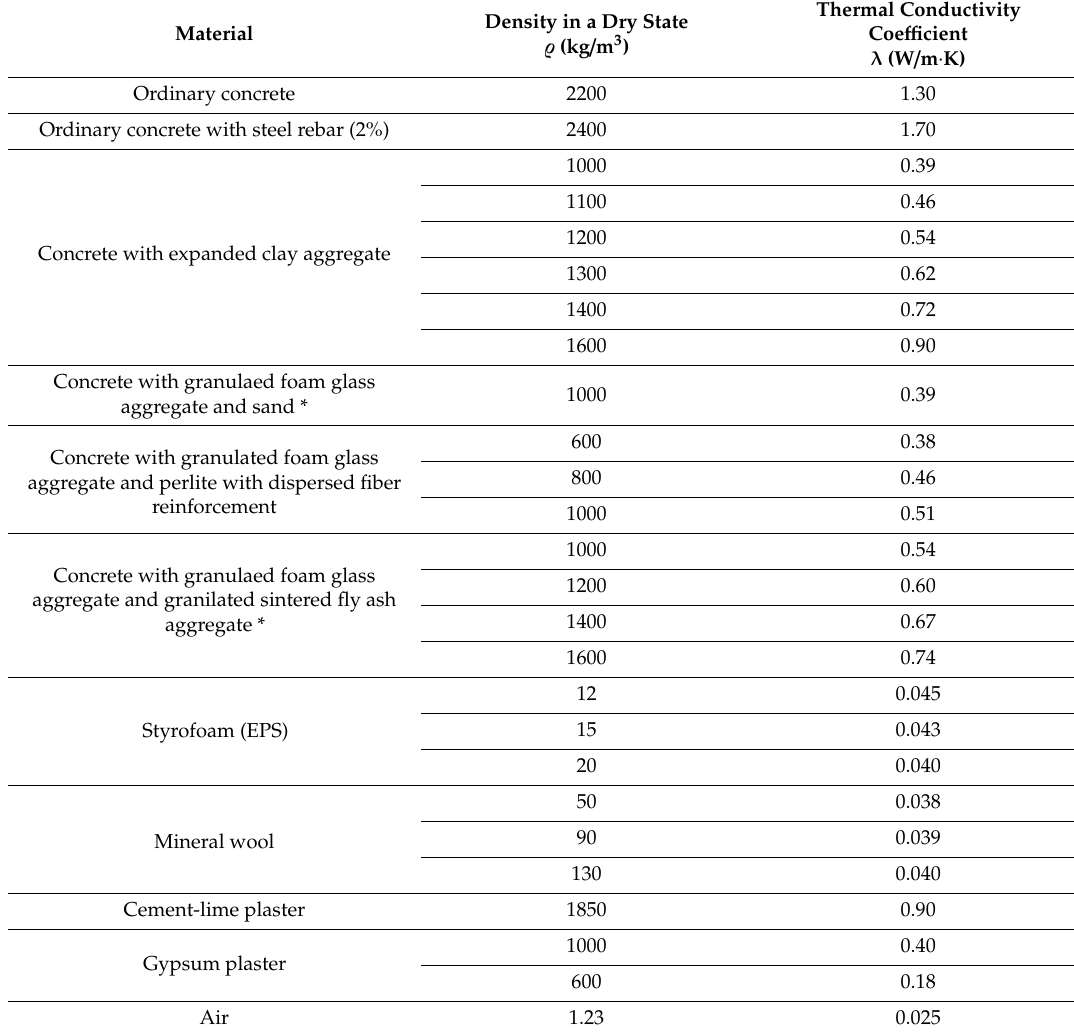
Table 3. Values for calculation of physical properties of the selected